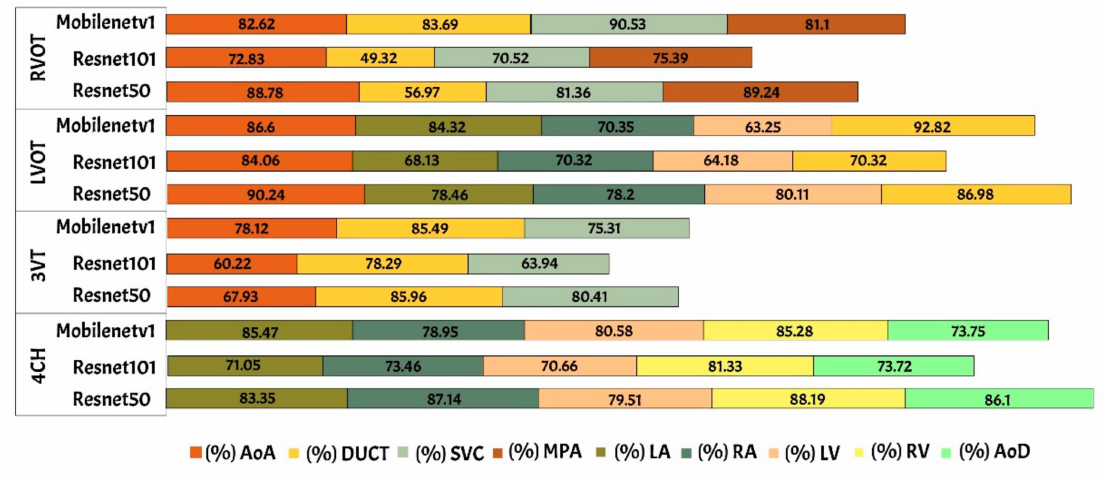
Figure 9. The DCS performance in heart chamber segmentation in four fetal heart standard